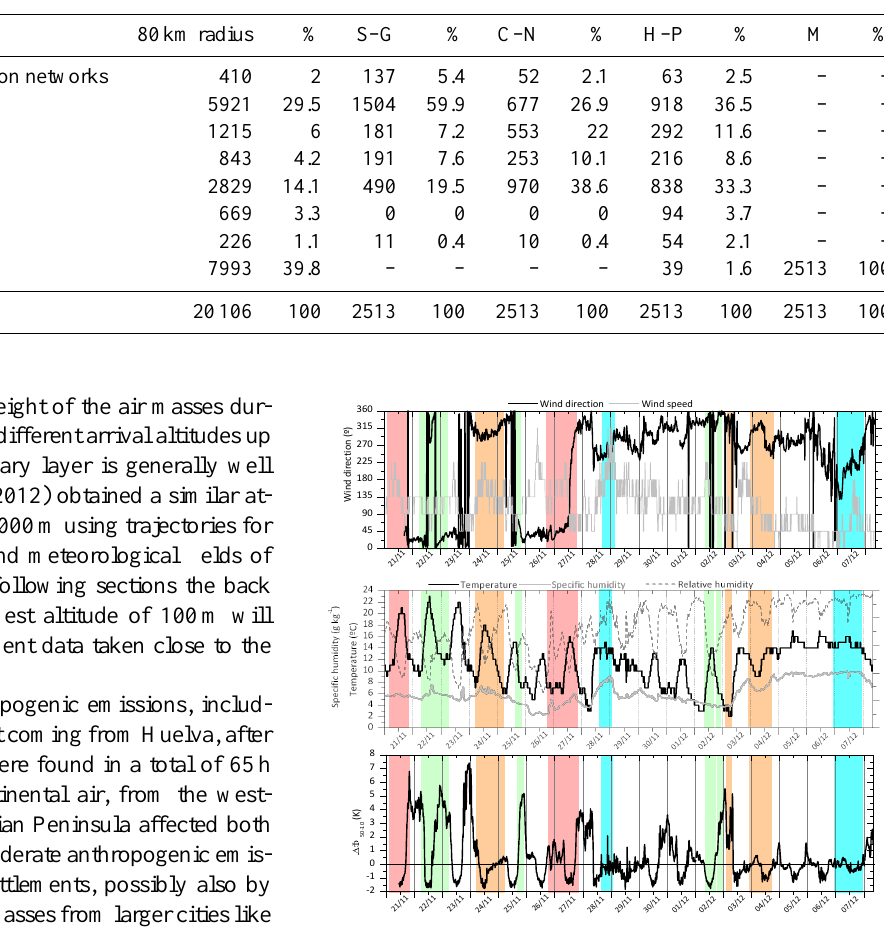
Fig. 4a. Temporal evolution of the wind direction and speed, tem- perature, relative humidity, specific humidity and potential temper- ature difference (between 50 and 10m) using 10min averages from the whole DOMINO campaign. Periods classified into distinct sec- tors of air mass origin are marked by brown (Huelva–Portugal), green (continental–north), red (Seville–Guadalquivir) and blue (ma- rine) shaded